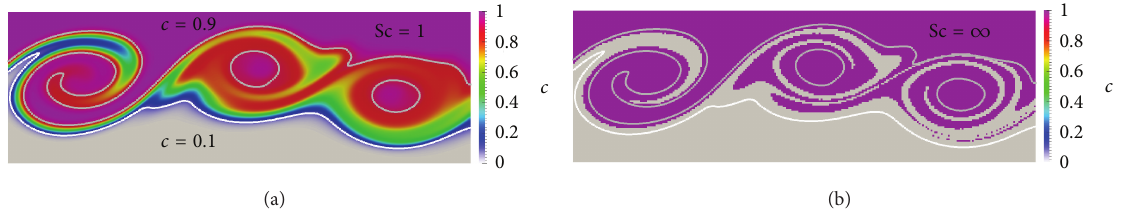
Figure 3: Comparison of instantaneous fiber concentration distributions (clipped). (a) Sc = 1 , (b) Sc = ∞ . Same isocontours of 𝑐 = 0.9 and 𝑐 = 0.1 for Sc = 1 are also added in (b) for comparison purpose. The fiber concentration has a sharp front for Sc = ∞ .